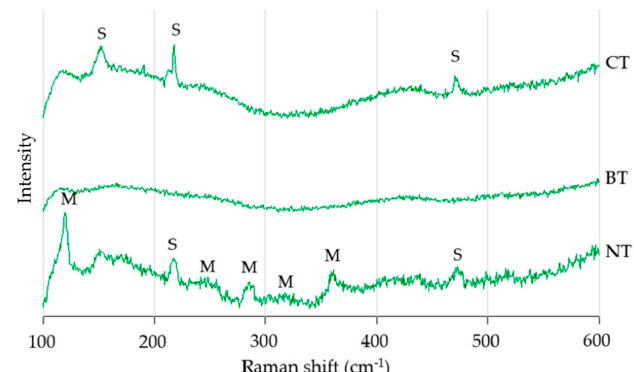
Figure 6. Raman spectra of untreated (NT) as well as chemically (CT) or biologically treated (BT) pinewood with characteristic bands of sulphur (S) and partially oxidised mackinawite (M) (figure adapted from [6]; see reference for details).